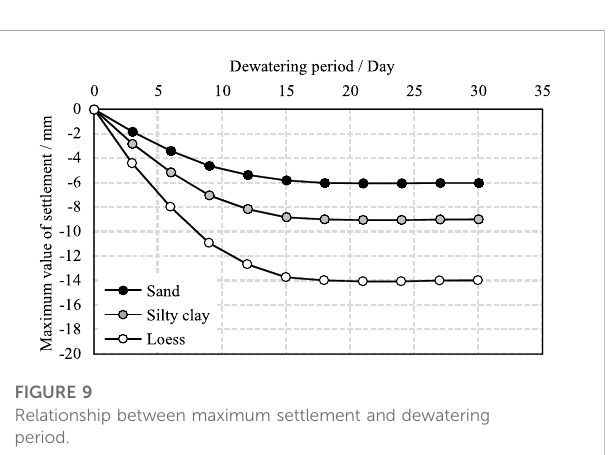
FIGURE 9 Relationship between maximum settlement and dewatering